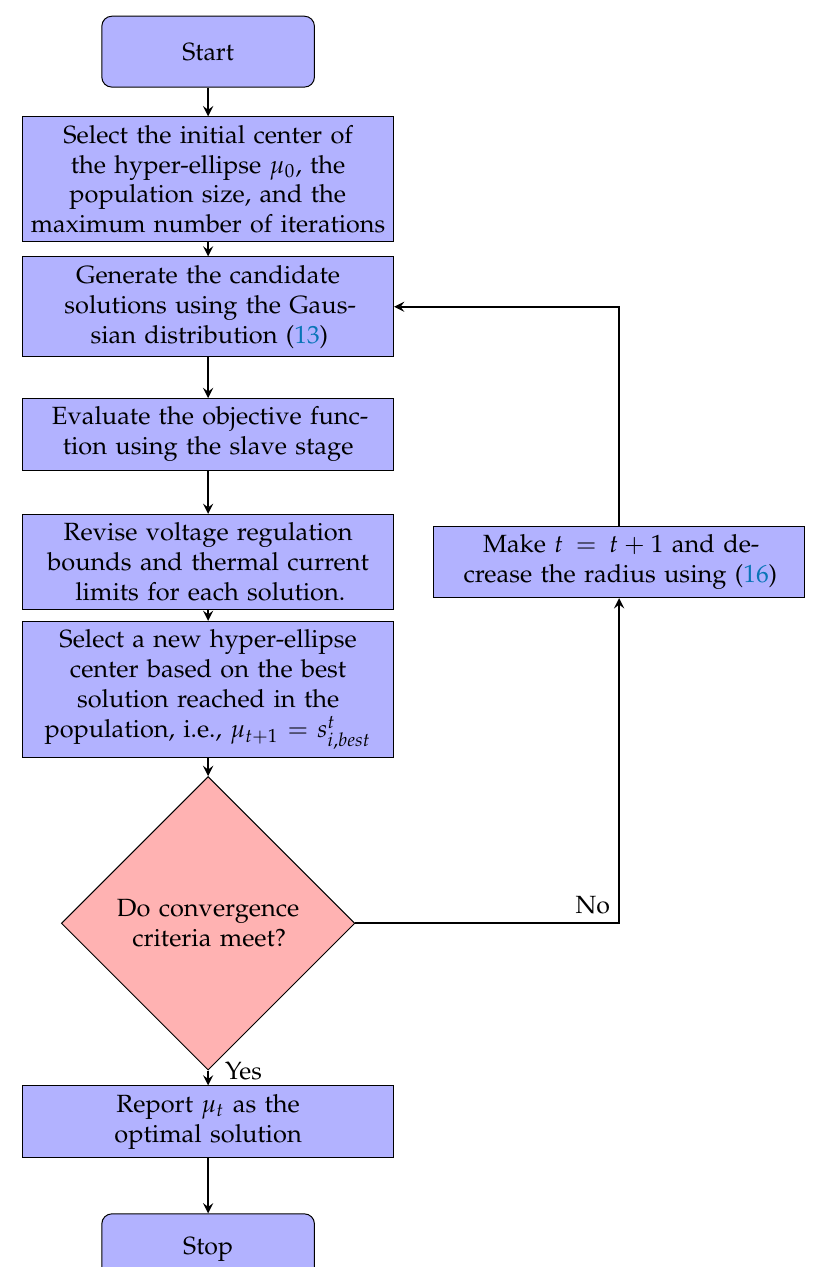
Figure 1. Flow chart for the discrete version of the vortex search algorithm [31].